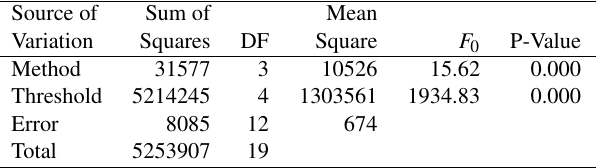
Table 10. ANOVA for DAP-TC (threshold is block).